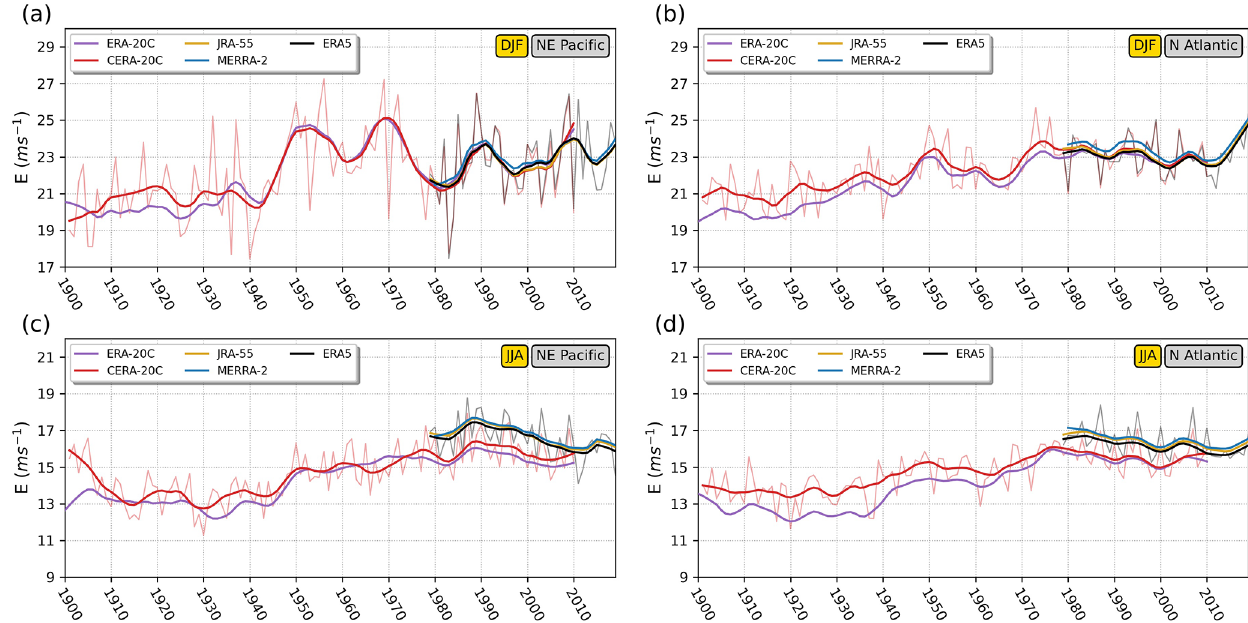
Figure 3. (a) LOWESS time series of DJF-mean E at 300hPa over NE Pacific based on the CERA-20C (red), ERA-20C (purple), JRA-55 (yellow), MERRA-2 (blue), and ERA5 (black) reanalysis. The thin red and black lines correspond to the original DJF-mean time series in CERA-20C and ERA5, respectively. (b) Same as panel (a) , but for the N Atlantic region. (c, d) Same as panels (a) and (b) , but for the JJA